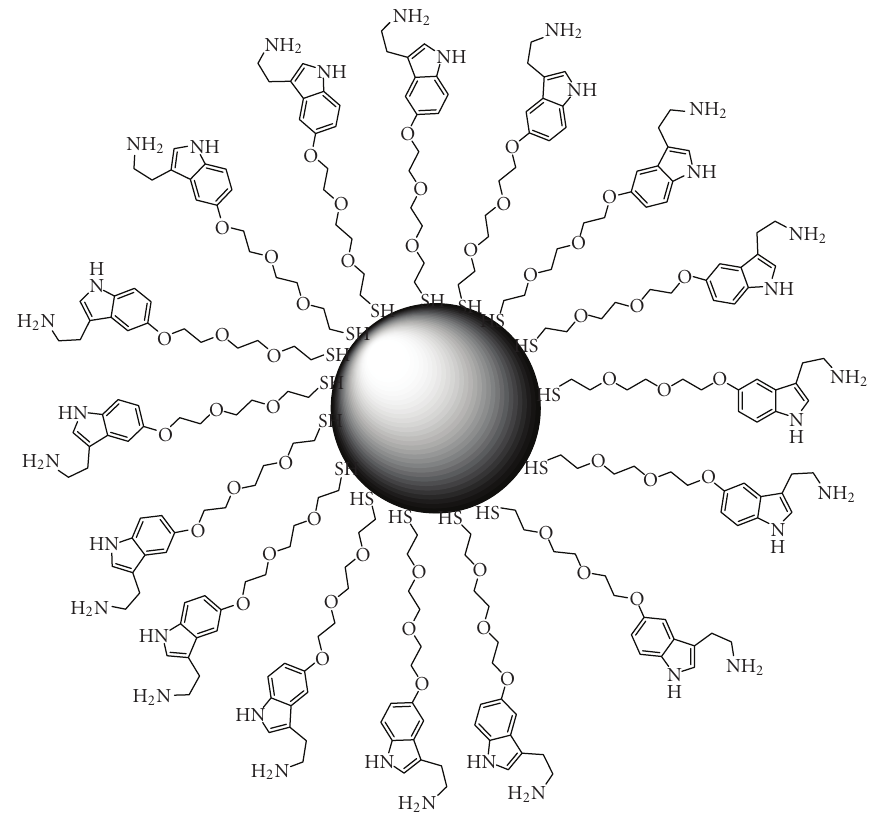
Figure 2: Serotonin-coated qdots used to label SERT-expressing cells.